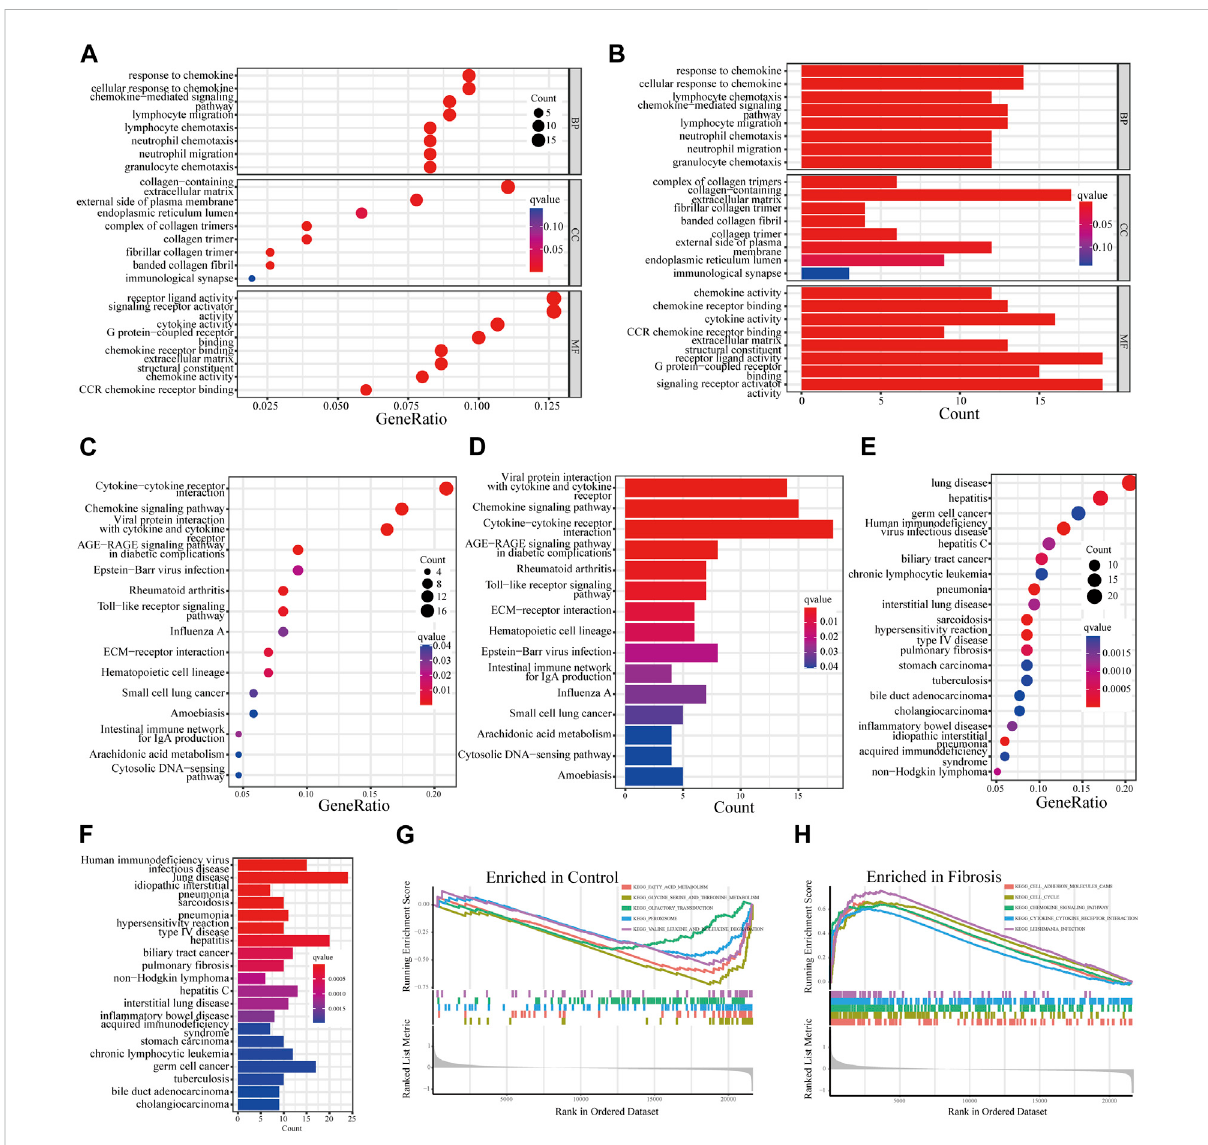
FIGURE 3 Functional enrichment analysis of DEGs. (A,B) GO analyses of DEGs. (C,D) KEGG analyses of DEGs. (E,F) DO analysis of DEGs. (G,H) GSEA